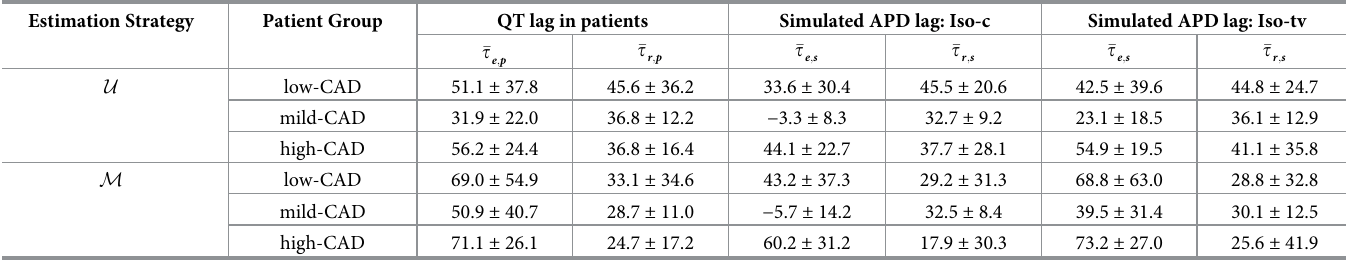
Table 2. Average values of the QT adaptation delays � t dial cell, � t and � t , with constant β -adrenergic stimulation (fourth column) and with the proposed time-varying β -adrenergic stimulation (fifth e ; s r ; s